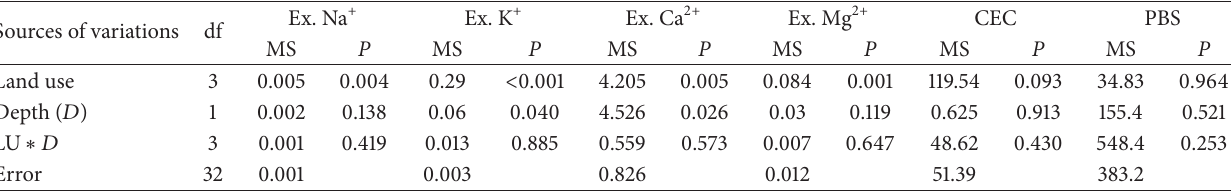
Table 6: Summary of ANOVA for exchangeable cations, CEC, and PBS in relation to land use and soil depths. Sources of variations